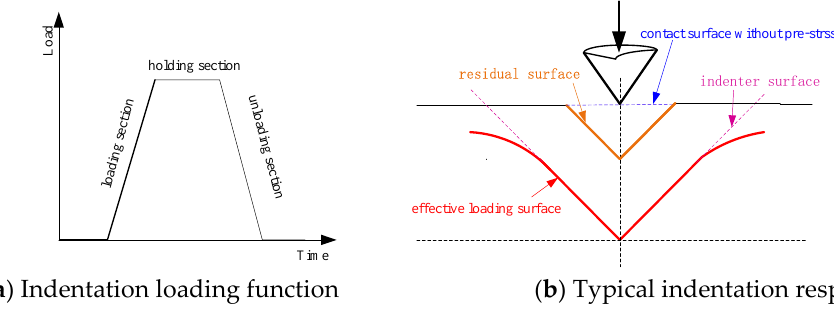
Figure 2. Typical indentation loading function and indentation change schematic diagram.